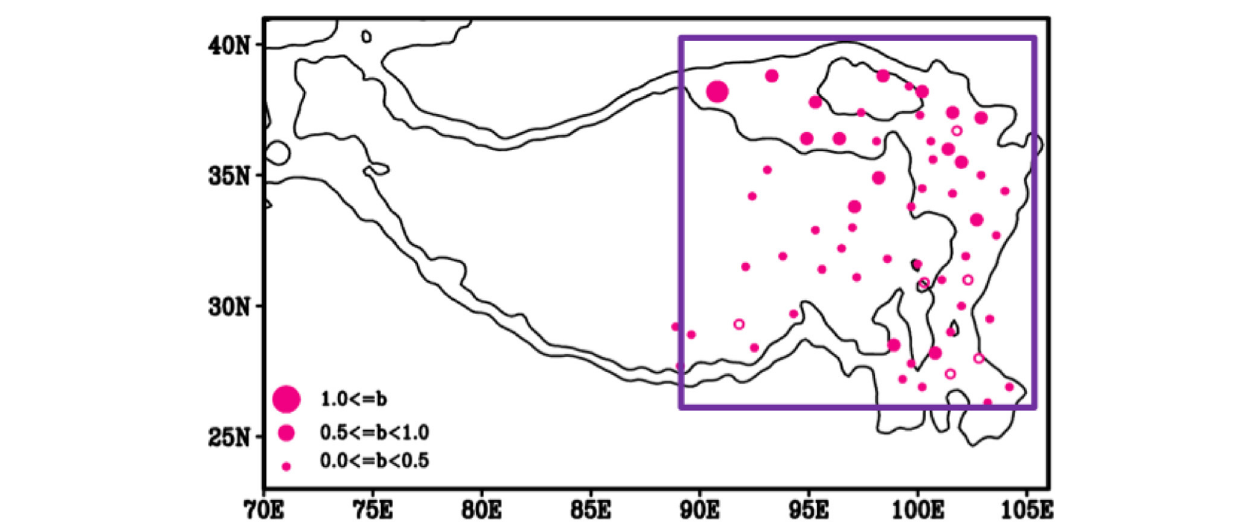
FIGURE 1 | Temperature changes at stations higher than 2,000m above mean sea level in the eastern Tibetan Plateau during the summers of 1980–2016 (units: ◦ C/decade; solid black lines represent the 2,000m and 3,000m height above mean sea level; the solid points indicate significant differences above the 95%